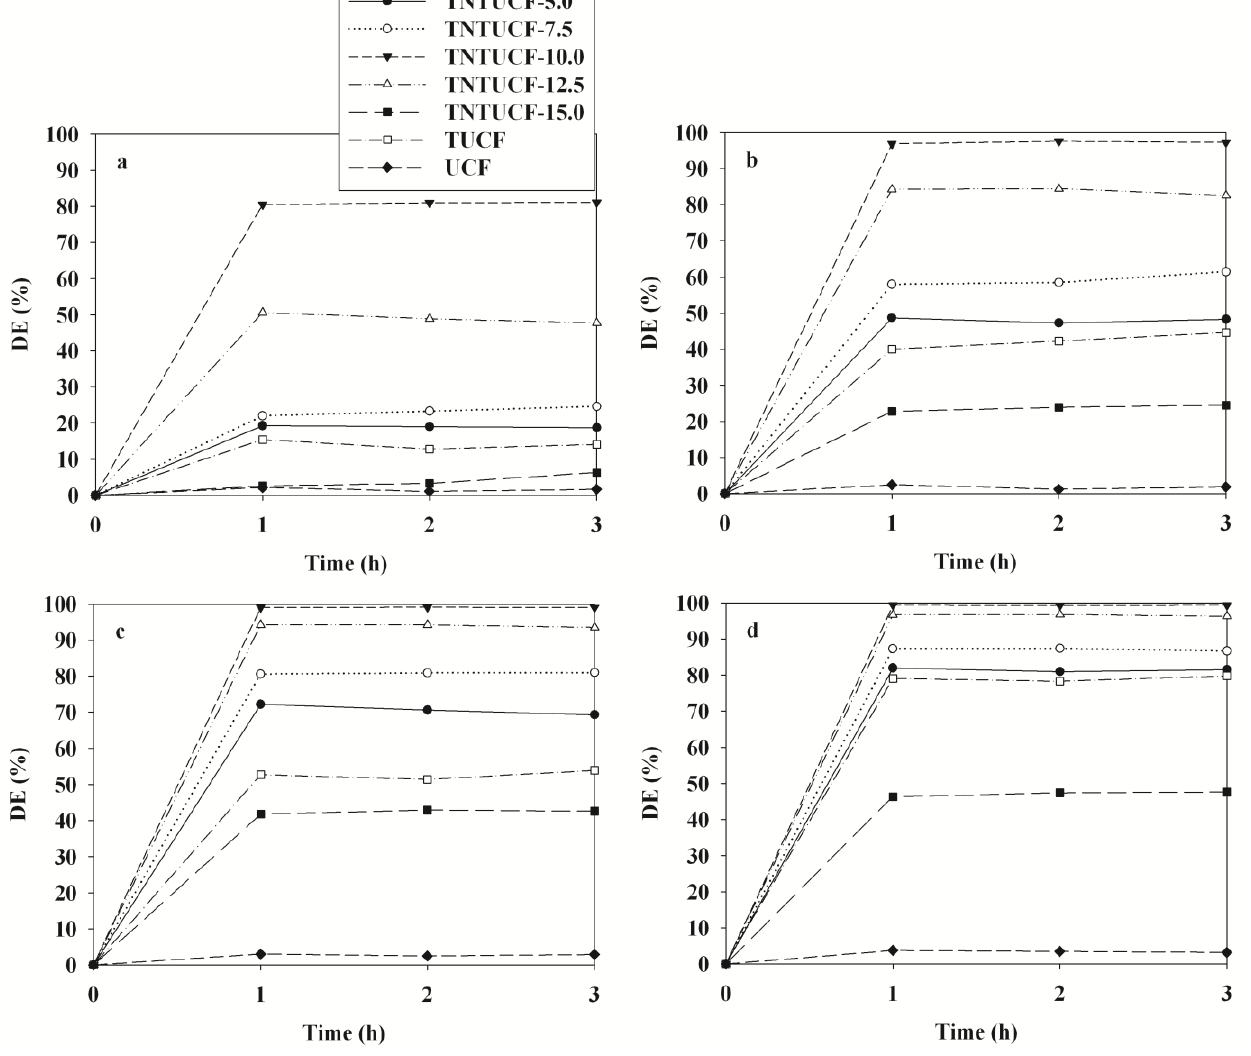
loadings (TNTUCF-5, 2